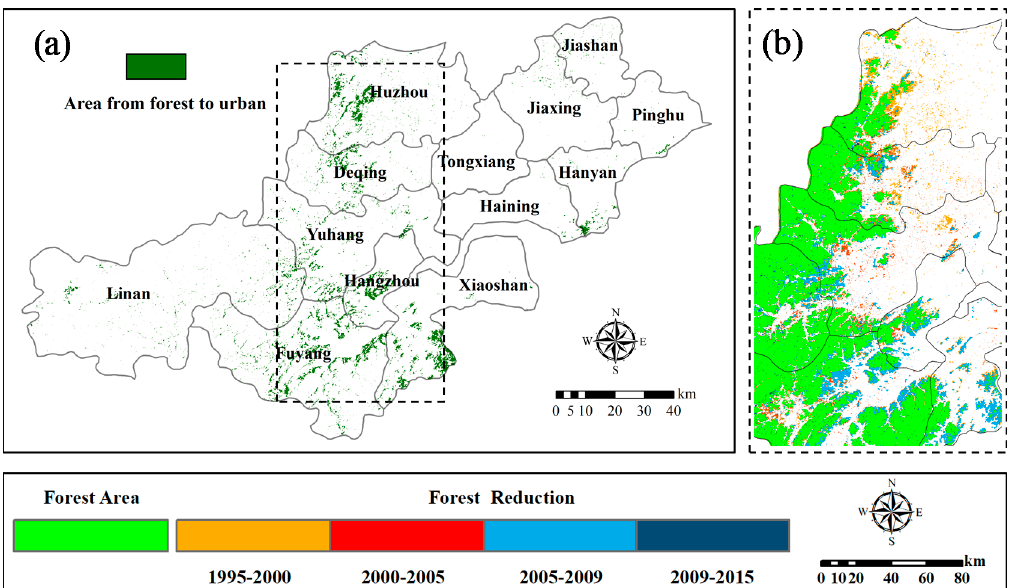
Figure 7. ( a ) Changing distribution of area from forest to urban land use, ( b ) different stages of forest changes.